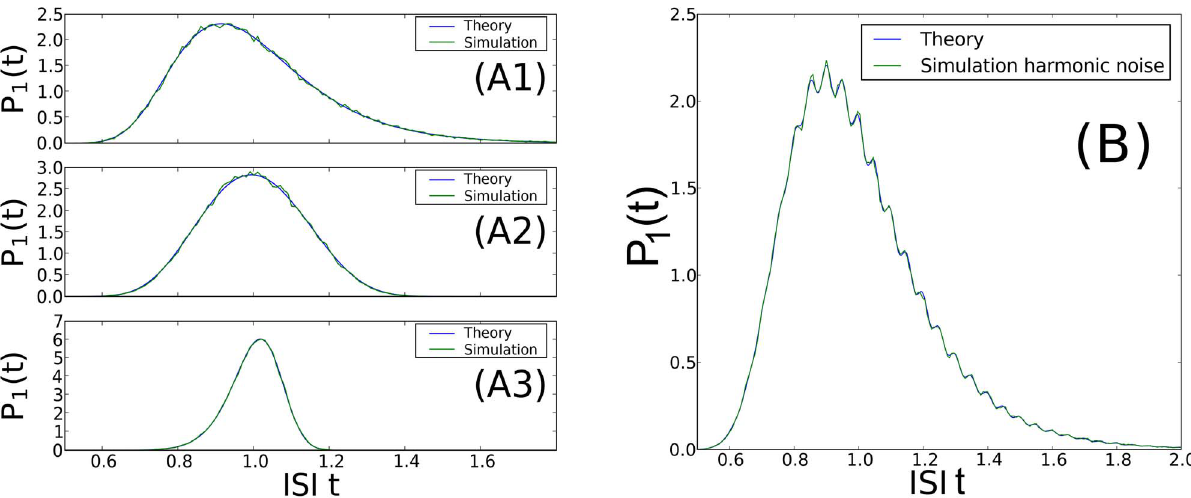
Figure 2. Comparison of ISI distributions P 1 ( t ) obtained from numerical simulation or theory Eqs.(6–9) for A and Eqs. (43–46) for B. A : ISI distributions for different frequency ratios: w ~ 0 : 2 (top panel), w ~ 0 : 5 (middle panel), or w ~ 0 : 8 (bottom panel). Parameters: Q ~ 30 , ^ ss x ~ 0 : 2 , ^ ss z ~ 0 : 3 , and ^ tt ~ 0 : 01 . B : Example of a multimodal ISI histogram at high relative driving frequency w , with harmonic noise input that was nearly periodic (large quality factor Q ~ 10 6 ). Parameters: ^ ss x ~ 0 : 2 , ^ ss z ~ 0 : 25 , ^ tt ~ 1 : 0 , w ~ 20 , m ~ 1 , v T ~ 1 and, consequently, r 0 ~ 1 = S T T ~ 1 .